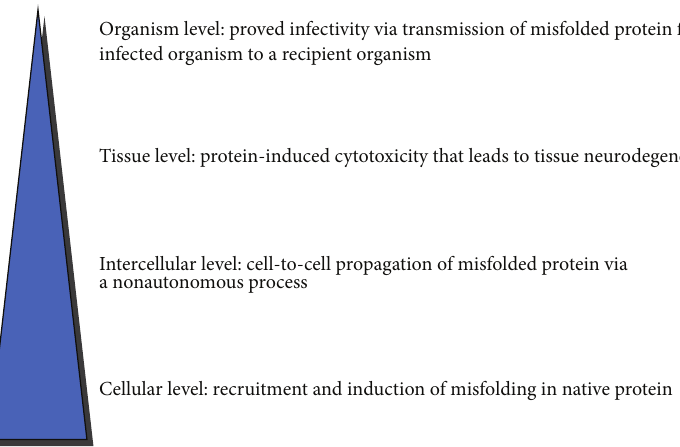
Figure 1: Diagram showing the criteria that must be satisfied for a disease to qualify as a prionopathy [19]. The most unique attribute of prion diseases is their transmissibility between individuals via transfer of pathological protein